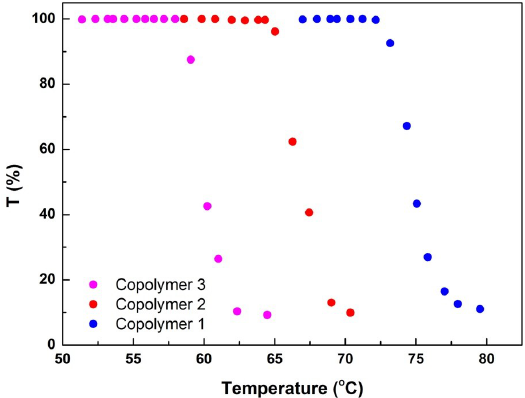
Figure 8. Temperature–dependent turbidity measurements of aqueous solutions containing copolymers 1, 2, and 3 (C, 1.0 wt%).